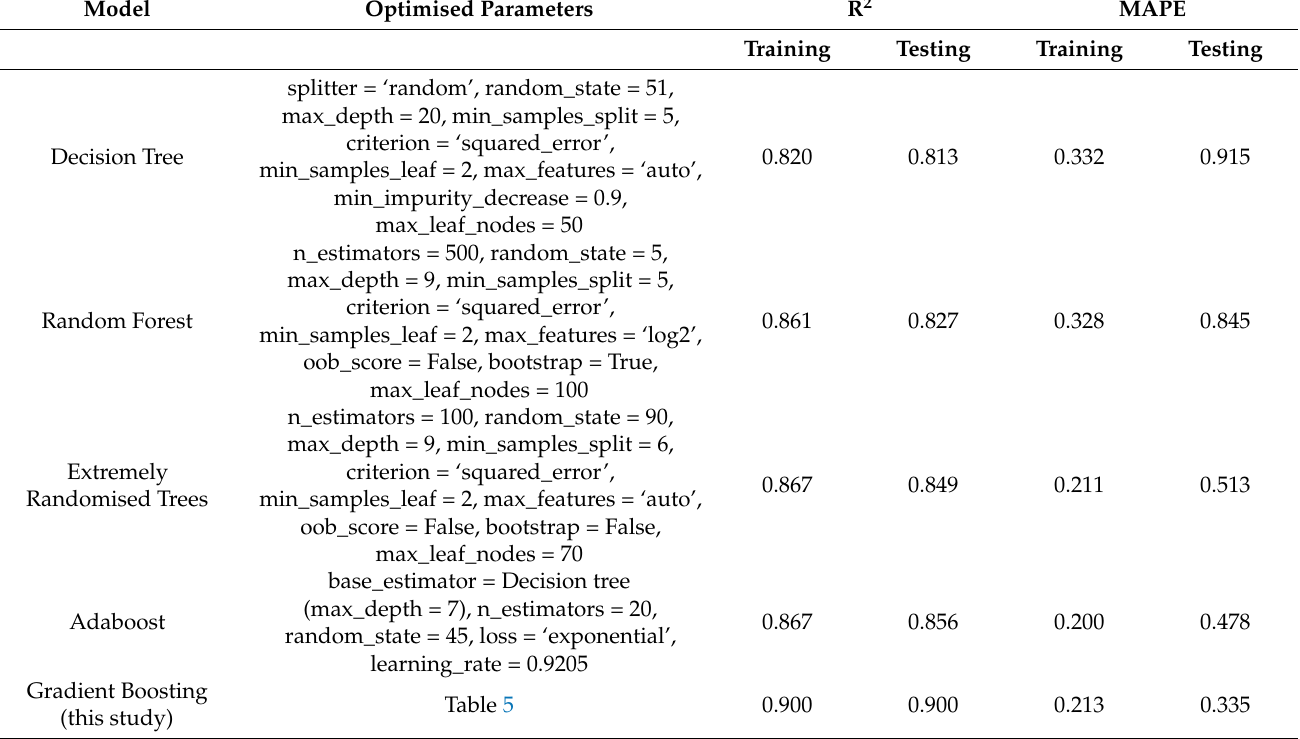
Table 7. ML performance of tree ensembles on the stabilised soil